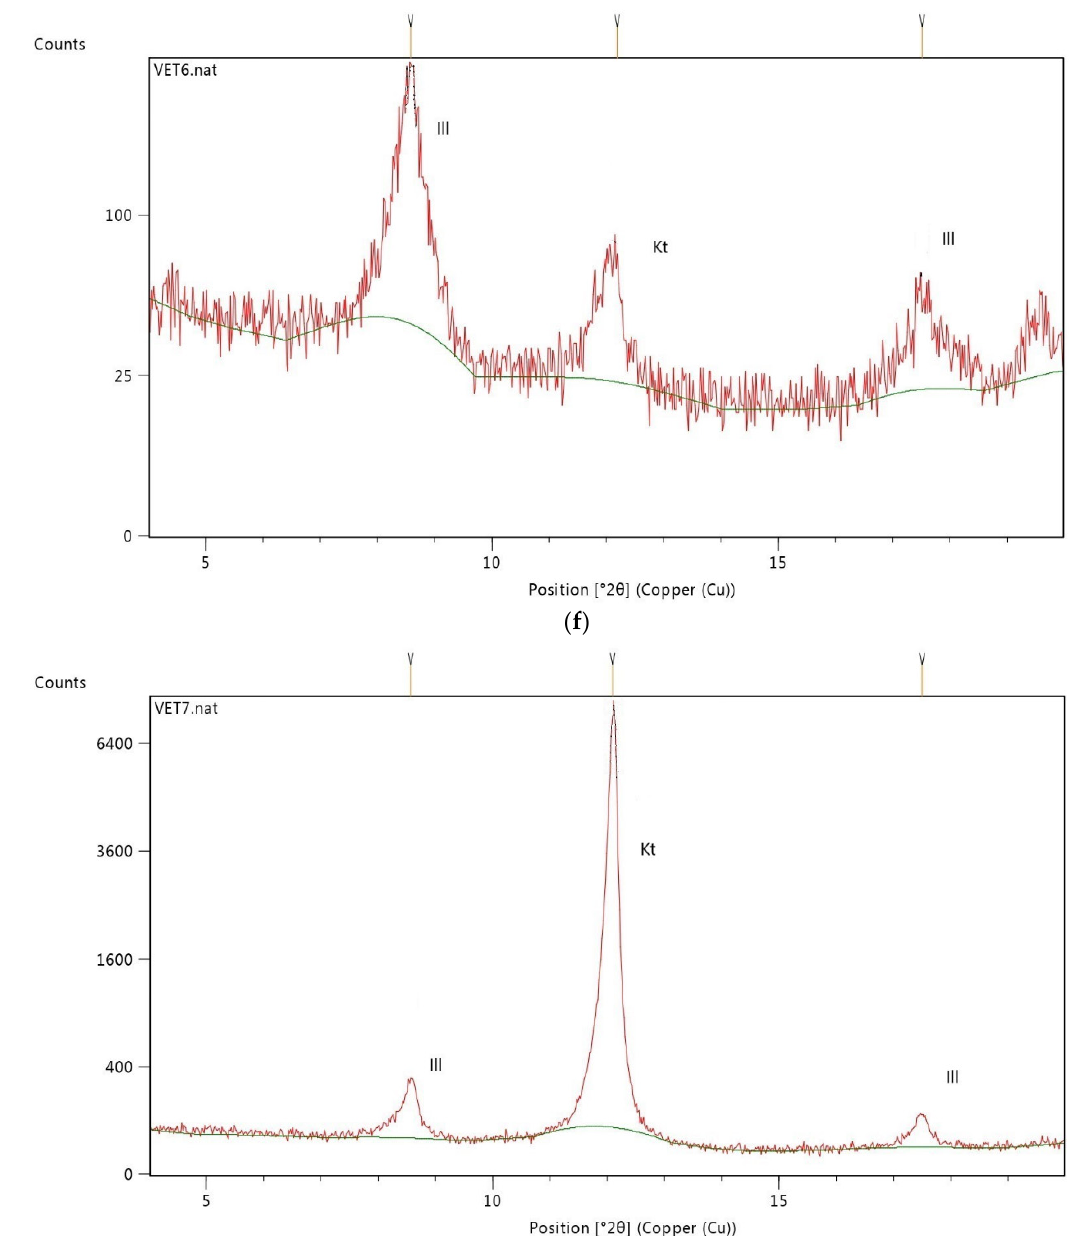
Figure 3. X ‐ ray diffraction patterns of air ‐ dried oriented aggregates ( a ) VET.1; ( b ) VET.2; ( c ) VET.3; Figure 3. X-ray di ff raction patterns of air-dried oriented aggregates ( a ) VET.1; ( b ) VET.2; ( c )